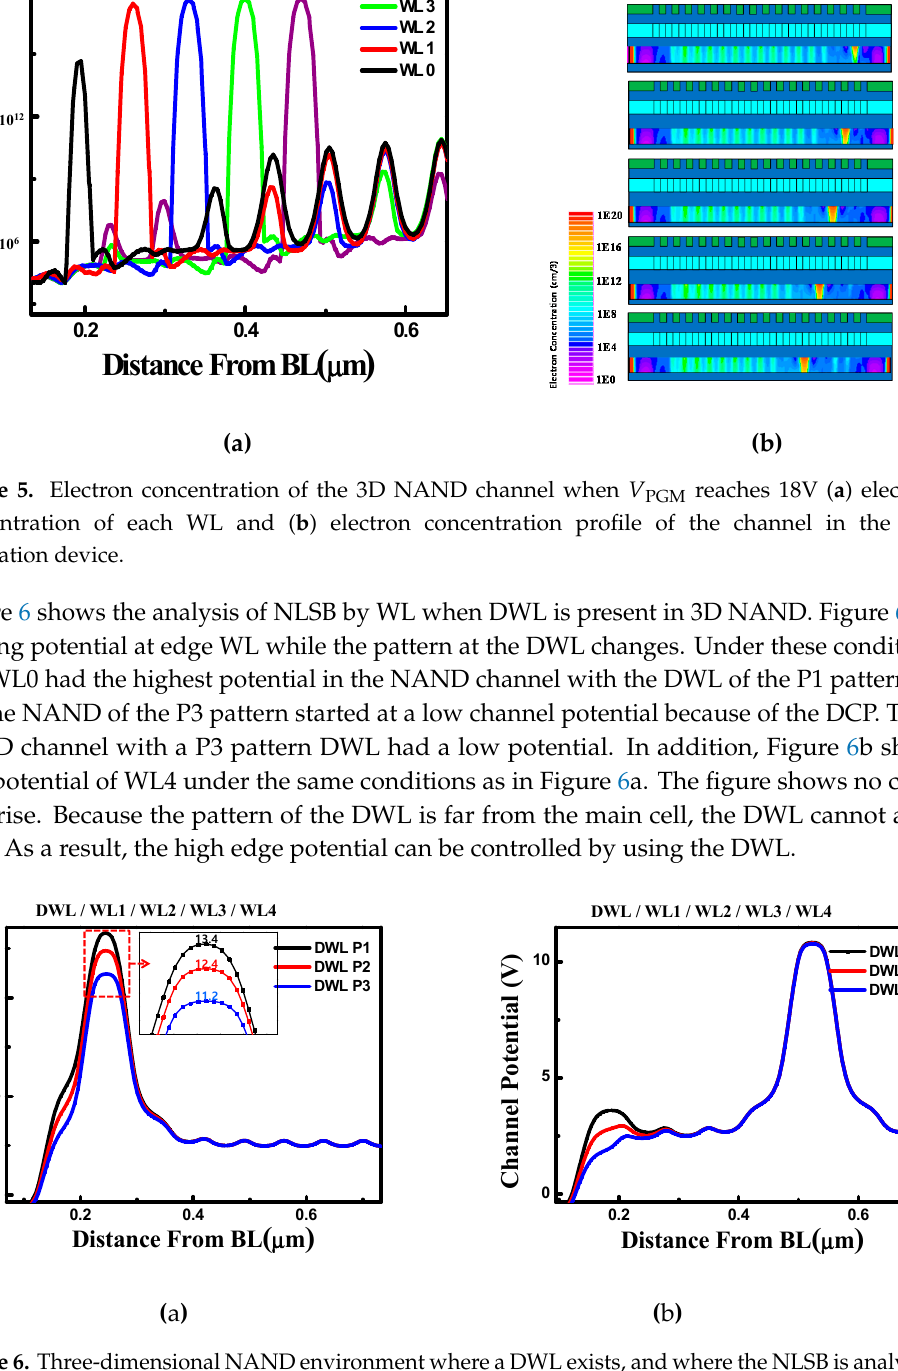
Figure 6. Three-dimensional NAND environment where a DWL exists, and where the NLSB is analyzed changing the pattern of the DWL ( a ) NLSB for the pattern of DWL at edge WL and ( b ) NLSB for the pattern of DWL in WL4 close to the main cell.